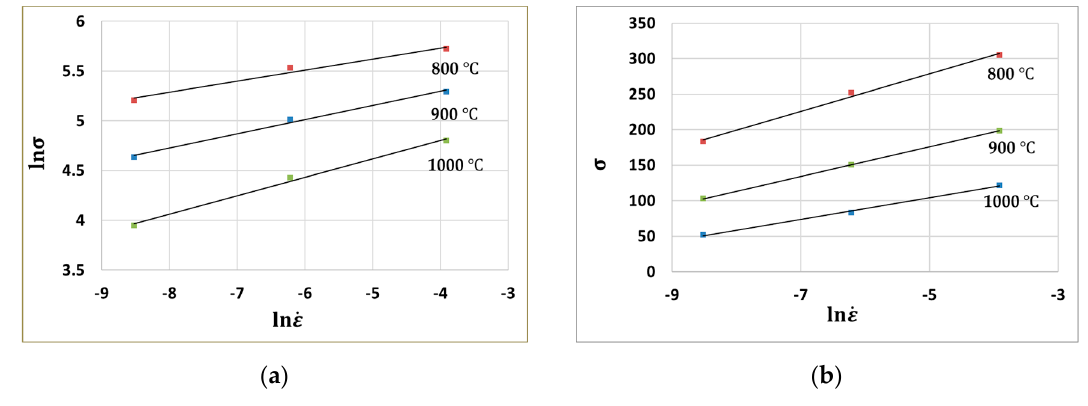
. ε plot when strain is